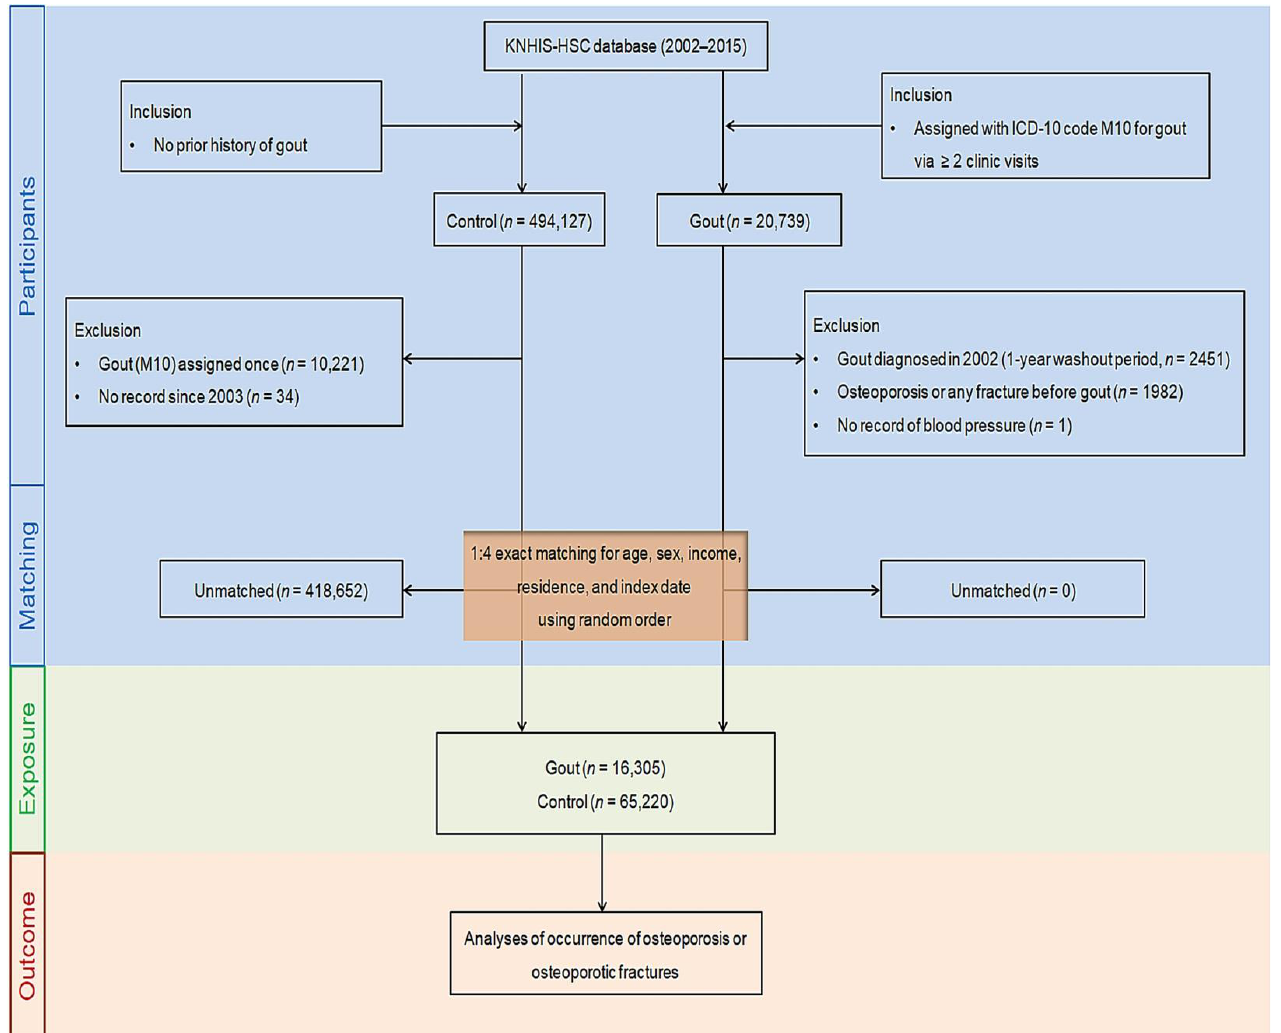
Figure 1. A summary chart illustrating the participant selection process used in the present study. Finally, 16,305 patients with gout were matched with 65,220 control people for age, sex, income, and region of residence out of 514,866 individuals in the Korean National Health Insurance Service-Health Screening Cohort (KNHIS-HSC) database. Abbreviations: KNHIS-HSC, the Korean National Health Insurance Service-Health Screening Cohort; ICD-10, the International Classification of Diseases, Tenth Revision, Clinical Modification.